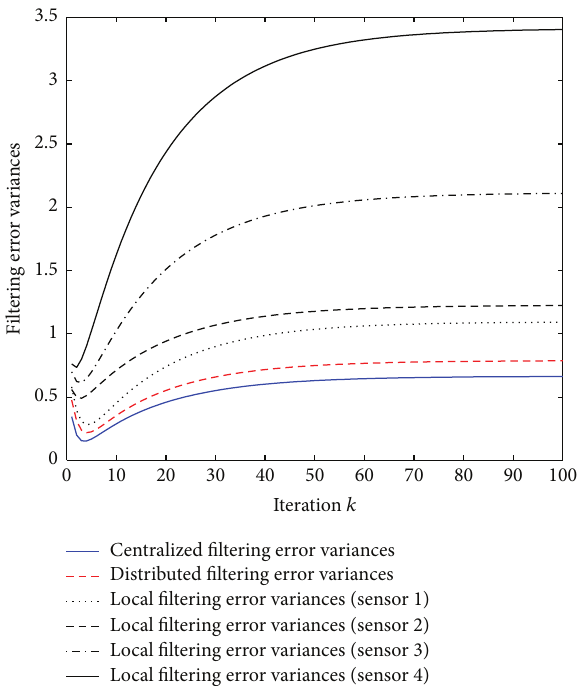
Figure 1: Error variance comparison of the centralized, distributed, and local filtering estimators.